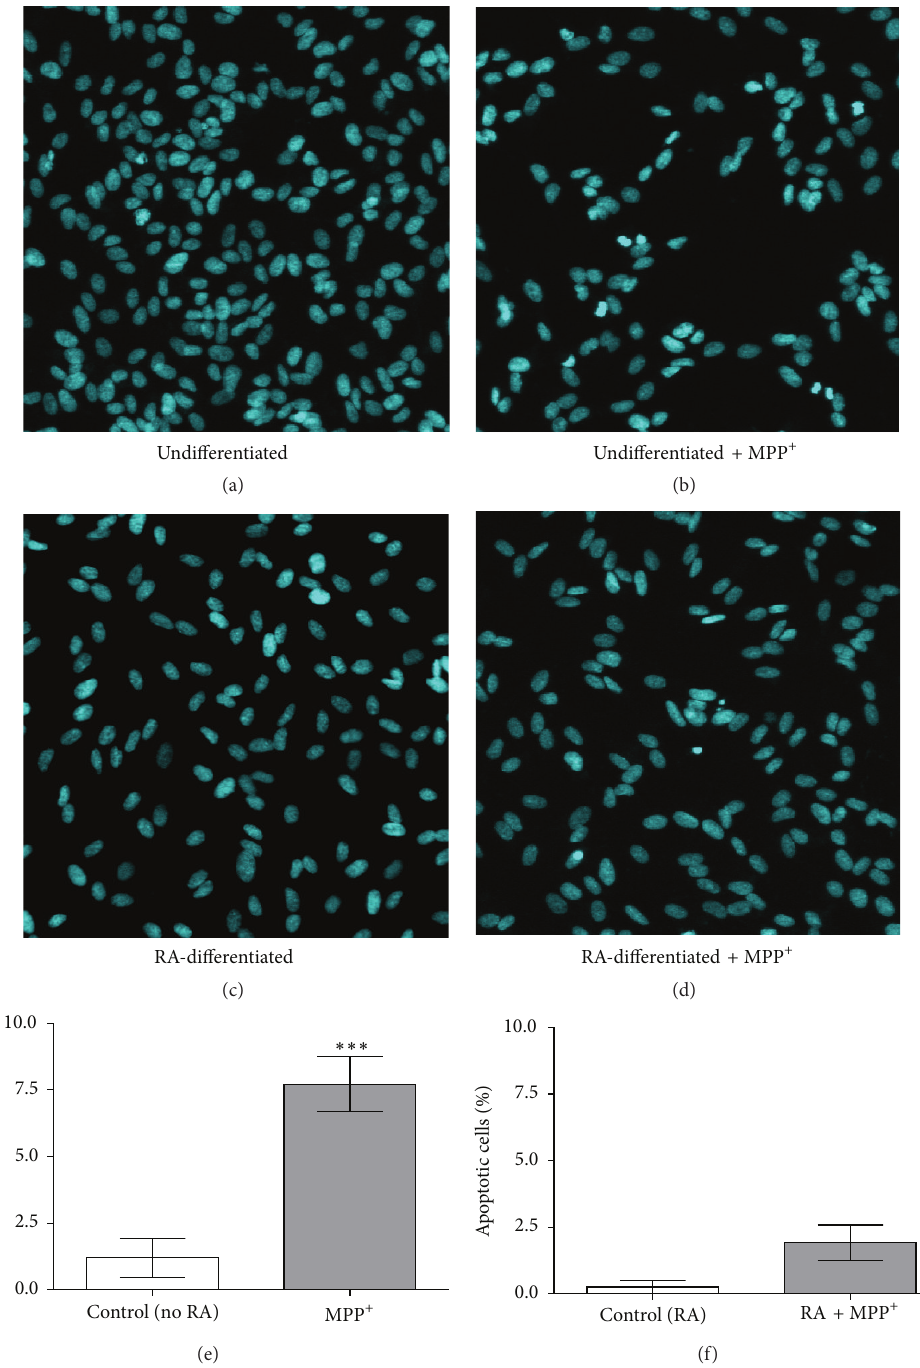
Figure 4: Effect of MPP + on nuclear morphology in undifferentiated and differentiated SH-SY5Y cells. Cells were undifferentiated (a and b) and were differentiated in 10- 𝜇 M retinoic acid (RA) for 3 days (c and d). Undifferentiated (b) and differentiated cells (d) were exposed to 500 and 1000 𝜇 M of MPP + for 24 hours, respectively. Apoptotic nuclear morphology was visualized by DNA staining with Hoechst 33258. Percentage of cells with apoptotic nuclei was calculated (e and f). Data are expressed as mean ± SEM ( 𝑛 = 3 ) of percentage to untreated cells. ∗∗∗ 𝑃 < 0.001